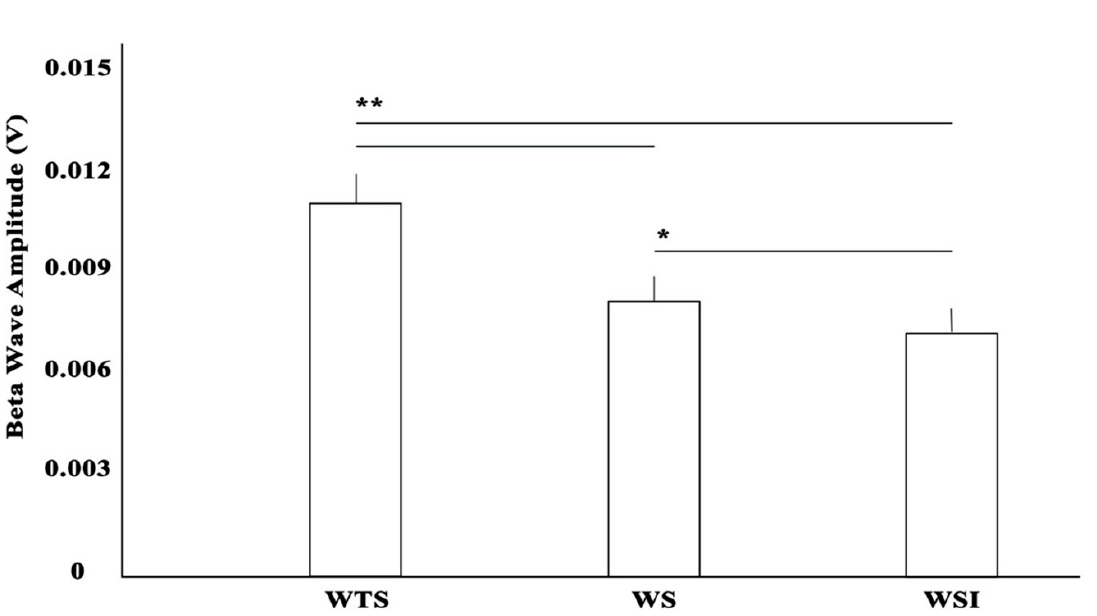
Figure 2. Beta wave amplitude signal in (* and ** for p < 0.05 and 0.01, respectively) different walking conditions (without shoes WTS, with shoes WS, with shoes and insoles WSI).